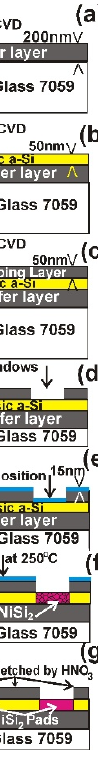
Figure 1. Schematic representation of the specimen preparation for the Ni-MILC experiment at 413 °C. ( a ) Deposition of 200 nm thick SiO 2 buffer layer on glass substrate by PECVD. ( b ) Deposition of 50 nm a-Si by LPCVD. ( c ) Deposition of a 50 nm thick SiO 2 capping layer by PECVD. ( d ) Open windows in the SiO 2 capping layer for the pad formation. ( e ) Deposition of 15 nm thick nickel. ( f ) Annealing at 250 °C for 10 min in order to form polycrystalline NiSi 2 in the area of the windows. ( g ) The nonreacted Ni is etched by HNO 3 .